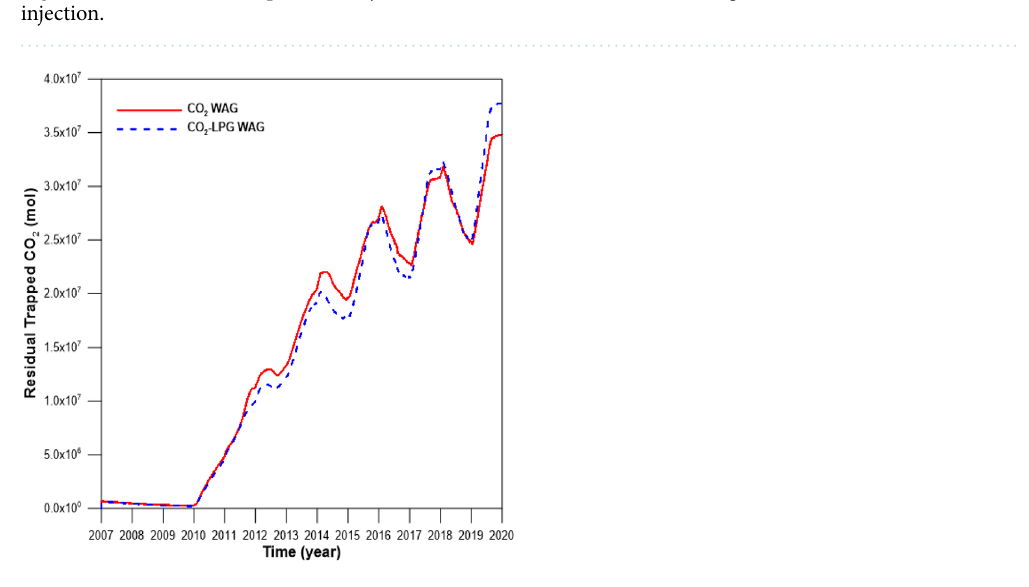
Figure 11. Residual trapped CO 2 for CO 2 and CO 2 -LPG WAG